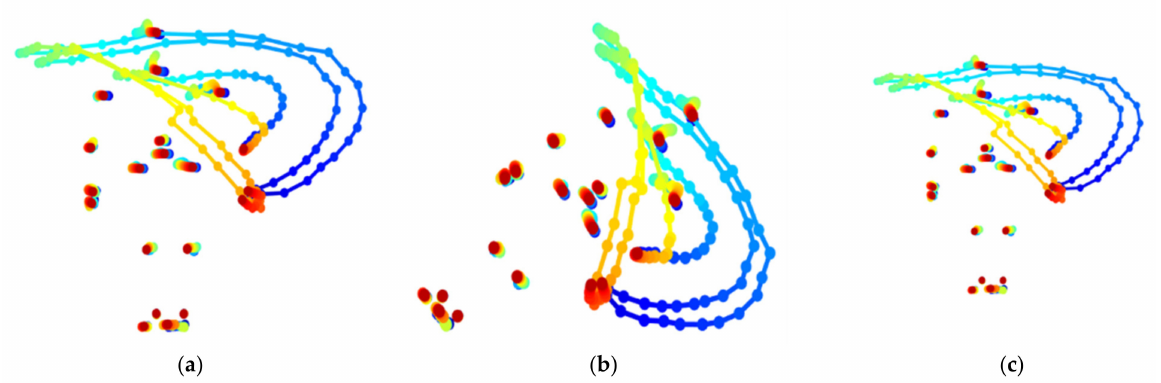
Figure 9. ( a ) Original, ( b ) rotated, and ( c ) scaled front views of ‘ SwipeLeft ’ action data in UTD-MHAD